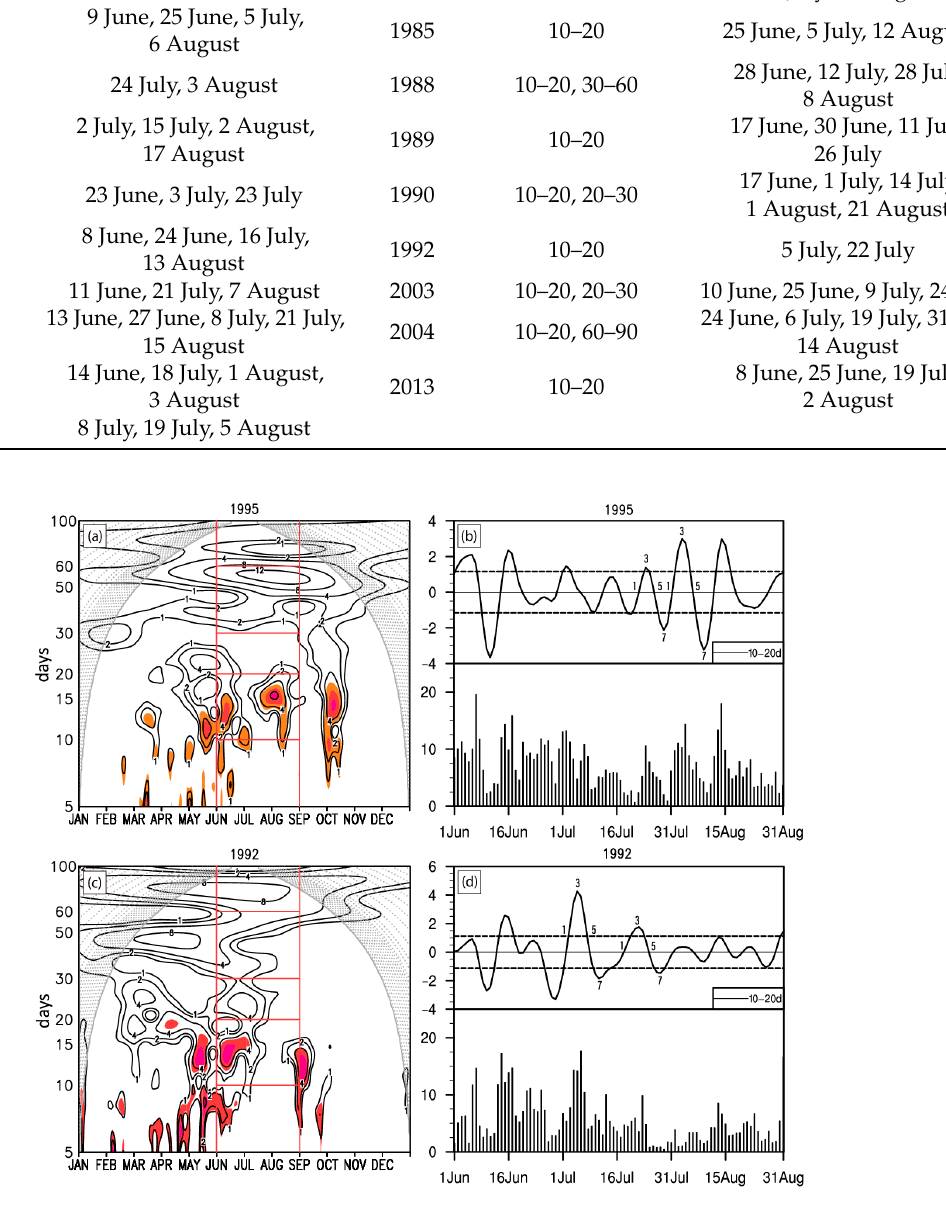
Figure 4. The wavelet analysis ( a , c ) of the representative-station regional mean of the daily precipitation series of Jan–Dec (shaded areas are significant at α = 0.05 level), the daily precipitation series ( b , d ) of June–August (bars, mm), and their filter curves ( b , d ) of 10–20 days (solid line, mm) in 1995 ( a , b ) and 1992 ( c , d ) in southern China. The area ( a , c ) between the vertical red lines represents the period from June to August. The horizontal red lines correspond to 10 days, 20 days, 30 days, and 60 days, respectively. “1, 3, 5, 7” ( b , d ) represents the phases 1, 3, 5, and 7 of LF precipitation, respectively. Dashed lines represent ±0.8 standard deviations of the daily representative-station regional mean LF precipitation series.